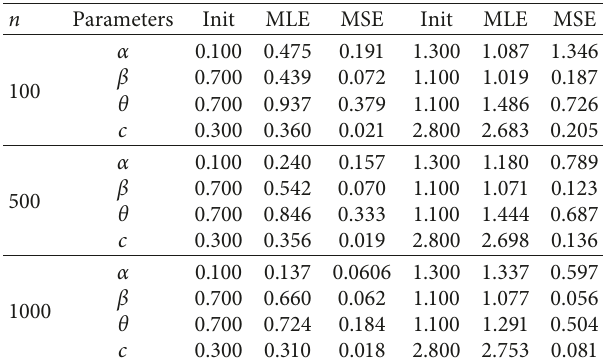
Table 4: MLE and MSE of NDWW distribution for set 3 and set 4.